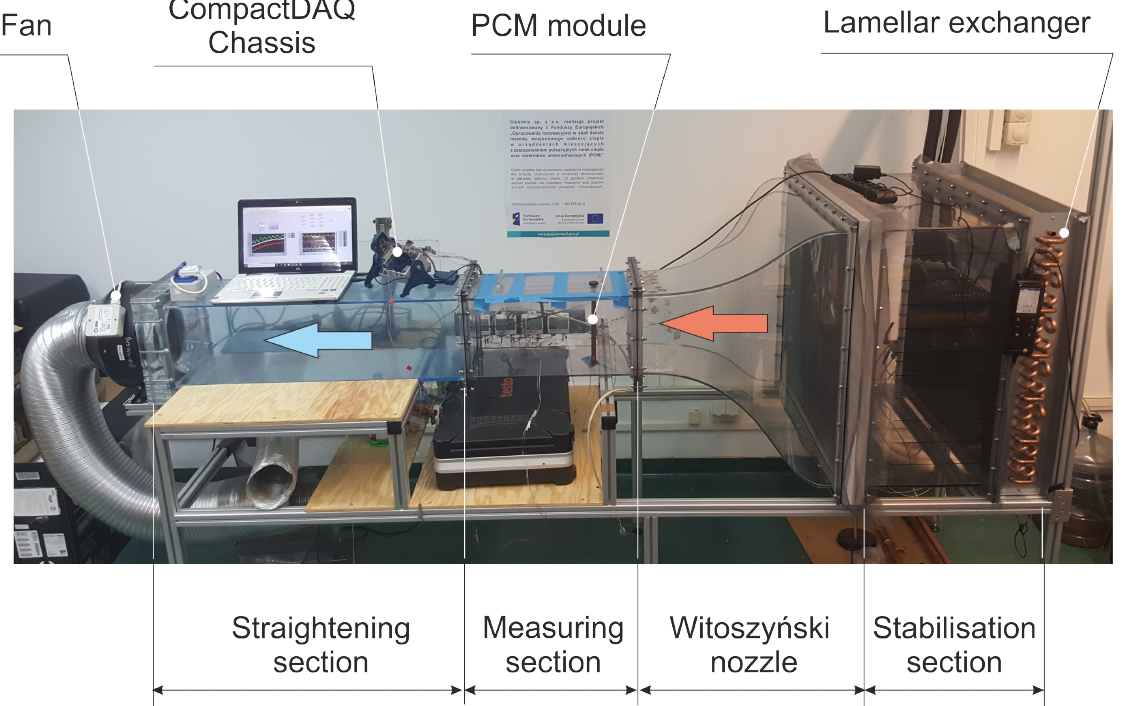
Figure 4. General view of the wind tunnel with installed PCM